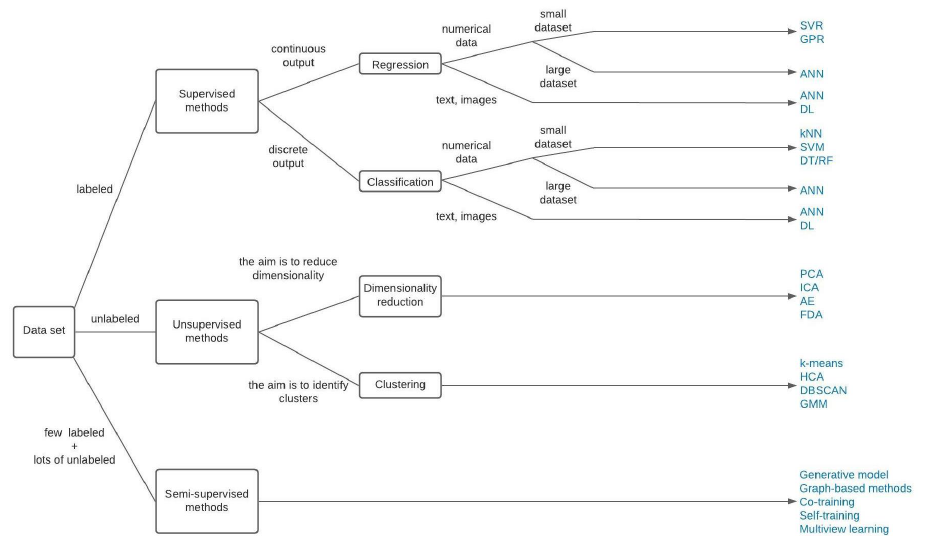
Figure 8. General guidelines for choosing appropriate ML